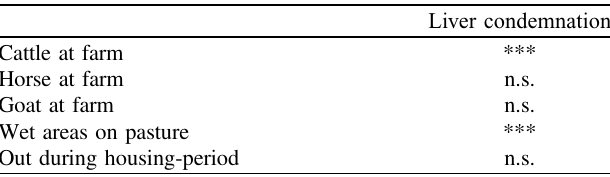
Table 5. Association between condemned liver reported by farmers and management factors ( n =